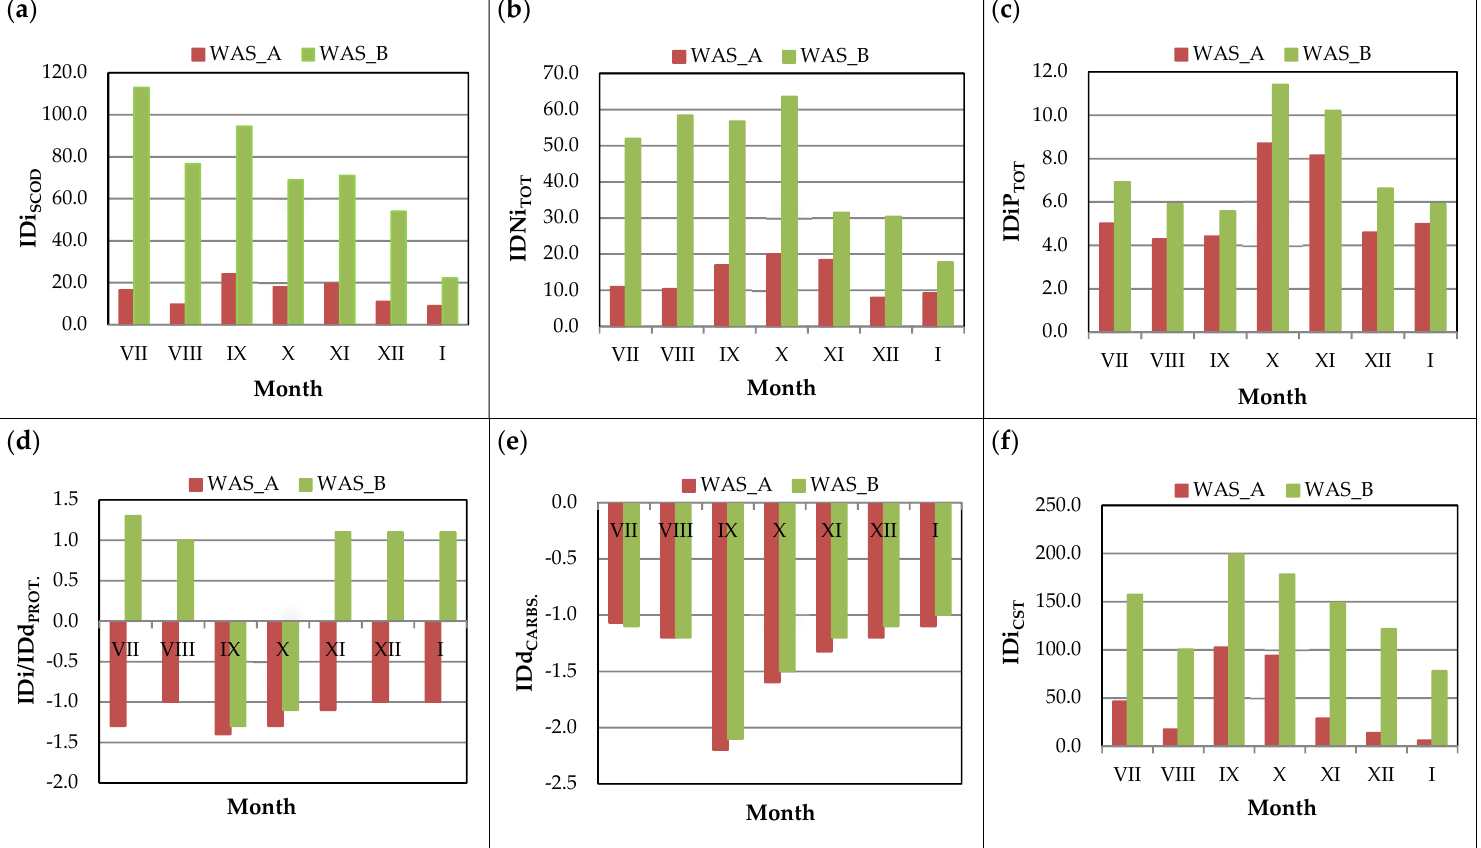
Figure A1. Values of indicators of the direct effects of WAS ultrasonic disintegration: ( a ) IDi SCOD ; ( b ) IDi NTOT ; ( c ) IDi PTOT ; ( d ) Idi/IDd PROT ; ( e ) IDd CARBS ; ( f ) IDi CST . WAS_A—waste activated sludge after pretreatment in the WK-2010; WAS_B—waste activated sludge after pretreatment in the ultrasonic washer.